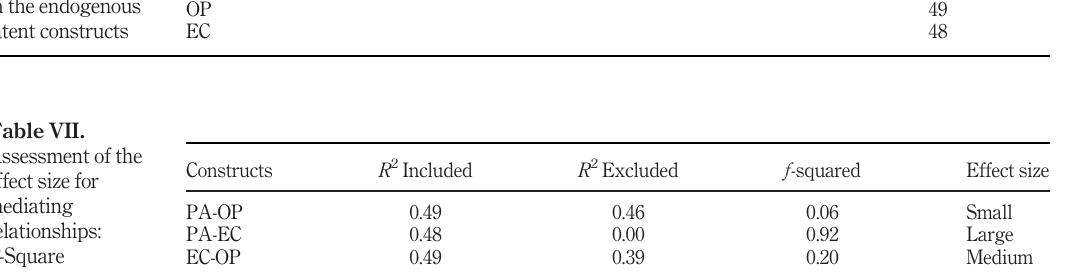
Figure 3. Structural model for mediation relationship